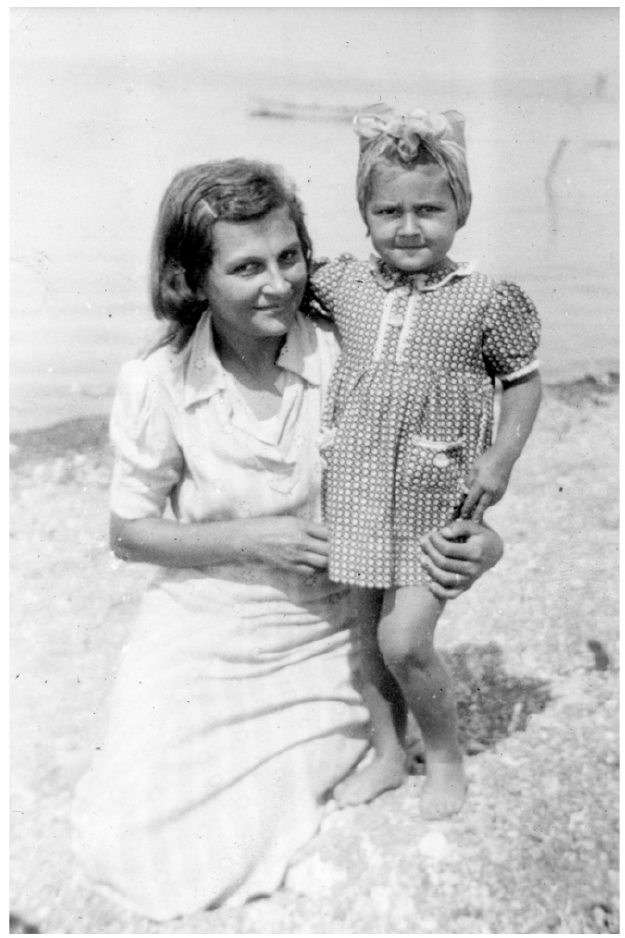
Figure 1 . The author’s grandmother and aunt, taken before their arrival in the US as displaced persons. Image reproduced with permission of Elena